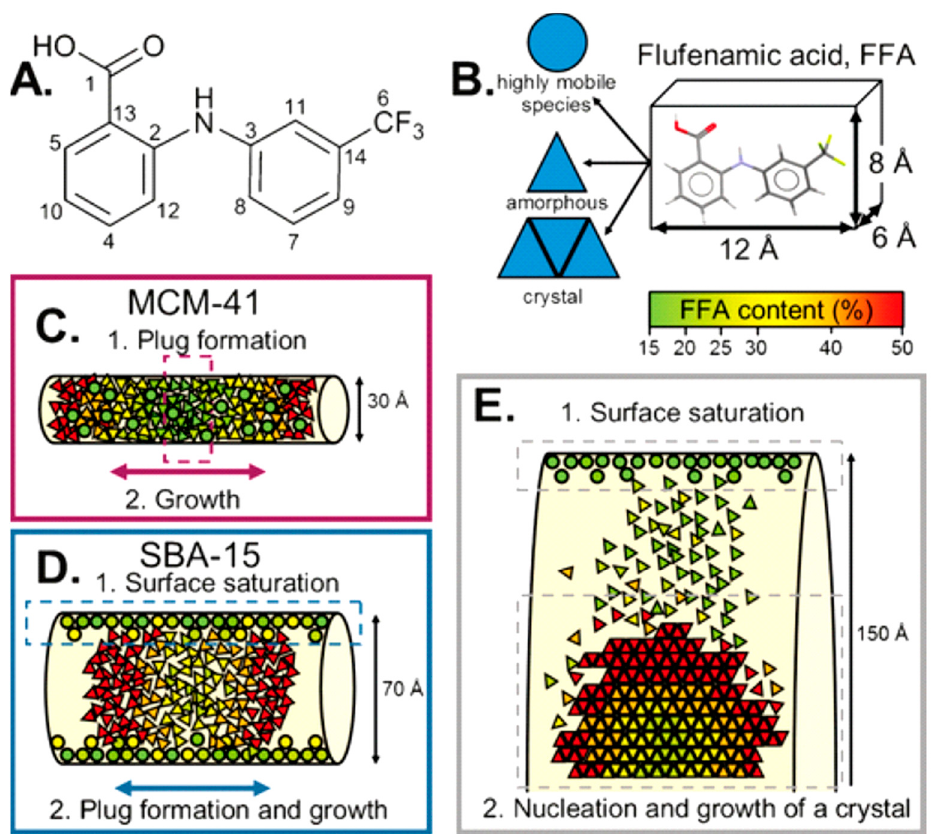
Figure 3. ( A ) Structure of flufenamic acid (FFA) with labelling of the carbon atoms. ( B ) Average dimensions of the FFA molecule and the three different states of FFA species inside the pores. ( C,D ) Different mechanisms for FFA adsorption and stabilisation of the amorphous state. ( E ) Mechanism of the formation of crystalline FFA form I in mesoscopic cellular foam (MCF). Reproduced with permission from [40].